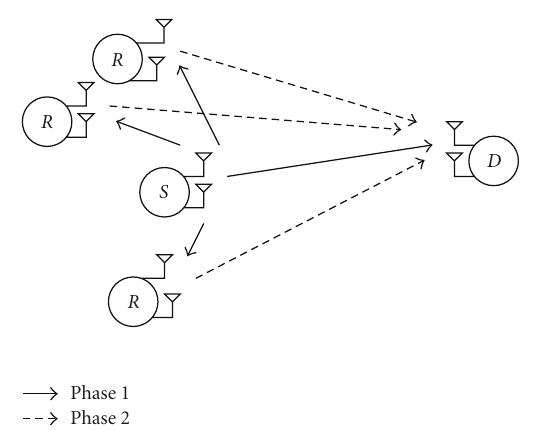
Figure 1: Two-phase relaying scheme: phase 1 (continuous line), phase 2 (dashed line). Source, relays, and destination nodes are denoted with S , R , D ,